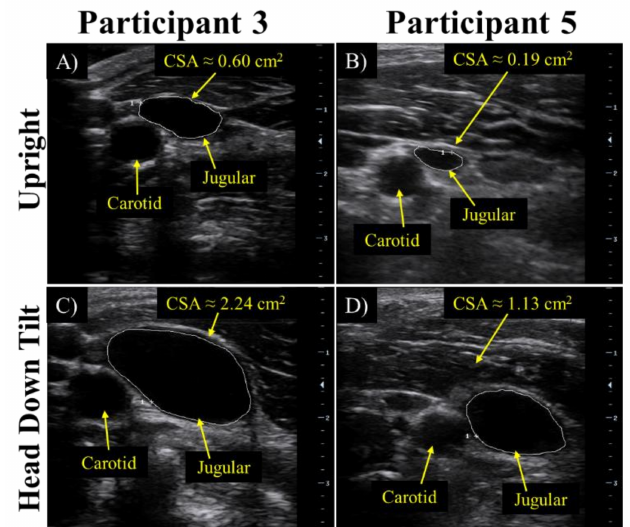
Figure 9. For the 30 min head down tilt at 15 ◦ , cross-sectional area data was obtained from ultrasound of the jugular vein as seen in upright position for ( A ) participant 3 and ( B ) participant 5, and for head down tilt for ( C ) participant 3 and ( D ) participant 5.